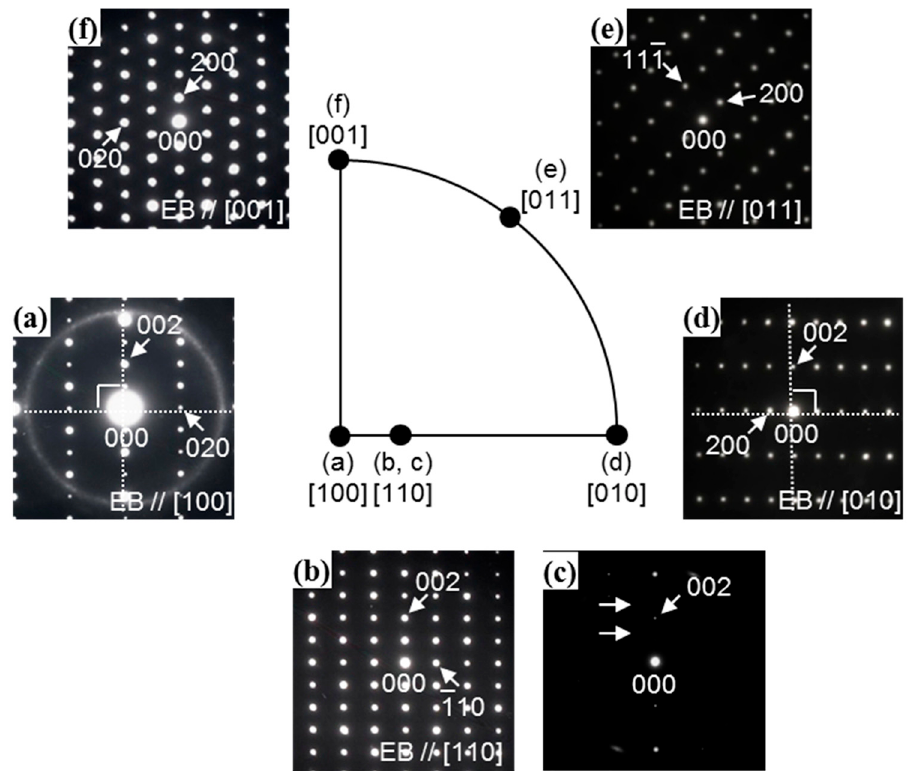
Figure 3. Electron diffraction patterns from the principal zone axes in a single phase of Zr 13 Pd 12 compound in the Zr-48 atom % Pd alloy aged at 1083 K for 720 ks, providing the space group: Cmc2 1 , C2cm , and Cmcm by extinction rules. ( a ) [100]; ( b ) [110]; ( c ) The observed pattern tilting around the c *-axis from the [110] zone axis; ( d ) [010]; ( e ) [011]; ( f ) [001] zone axes.